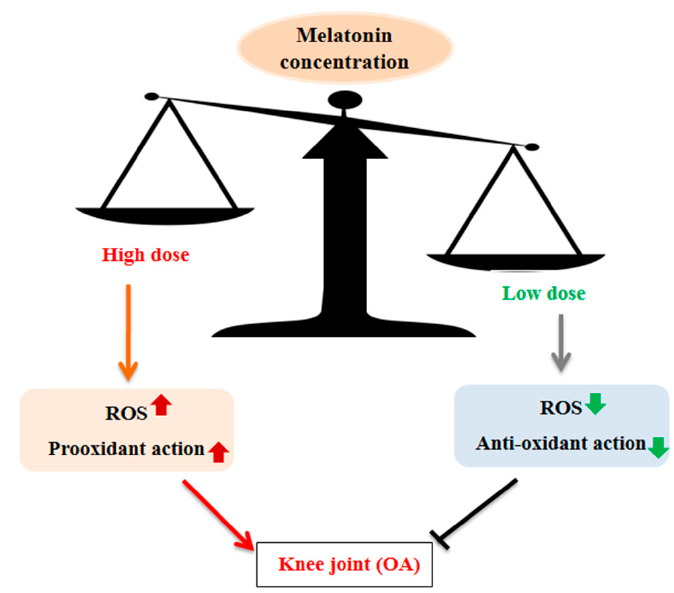
Figure 2. In vitro studies show that high concentrations of melatonin lead to increases in reactive oxygen species (ROS) expression, oxidative stress, and inflammatory cytokines, with low concentrations of melatonin exhibiting the opposite e ff ects, including enhanced antioxidant action and reduced ROS expression. Low concentrations may inhibit cartilage degradation by regulating pro-inflammatory cytokines and ROS.